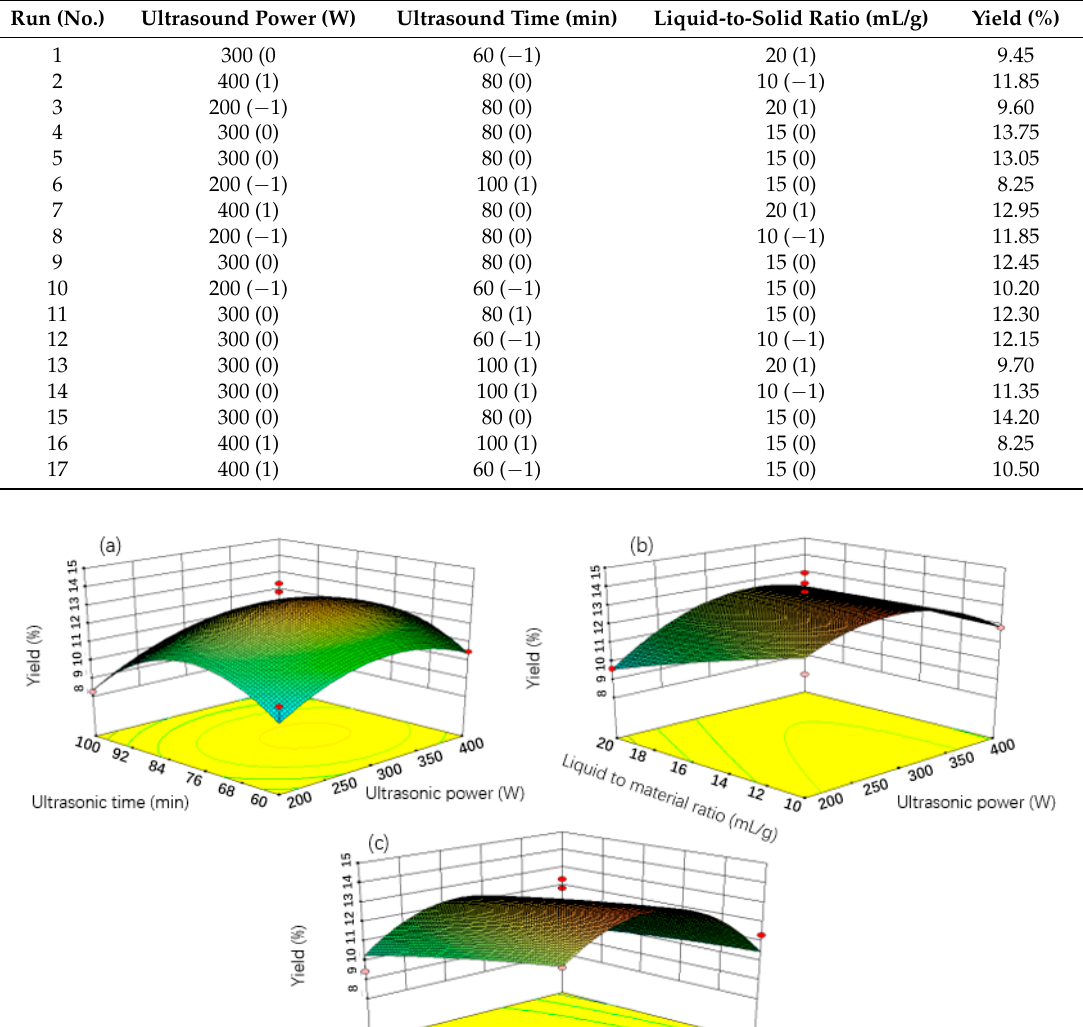
Table 1. Box–Behnken design for independent variables and observed responses of oligomeric procyanidins (OPC) from ultrasonic extraction.